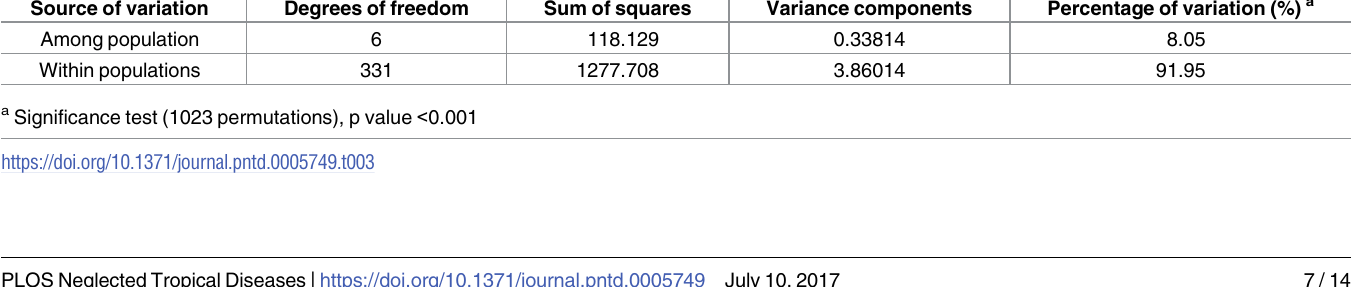
Table 3. Analysis of molecular variance(AMOVA) for S . japonicum population from different endemic municipalities. Source of